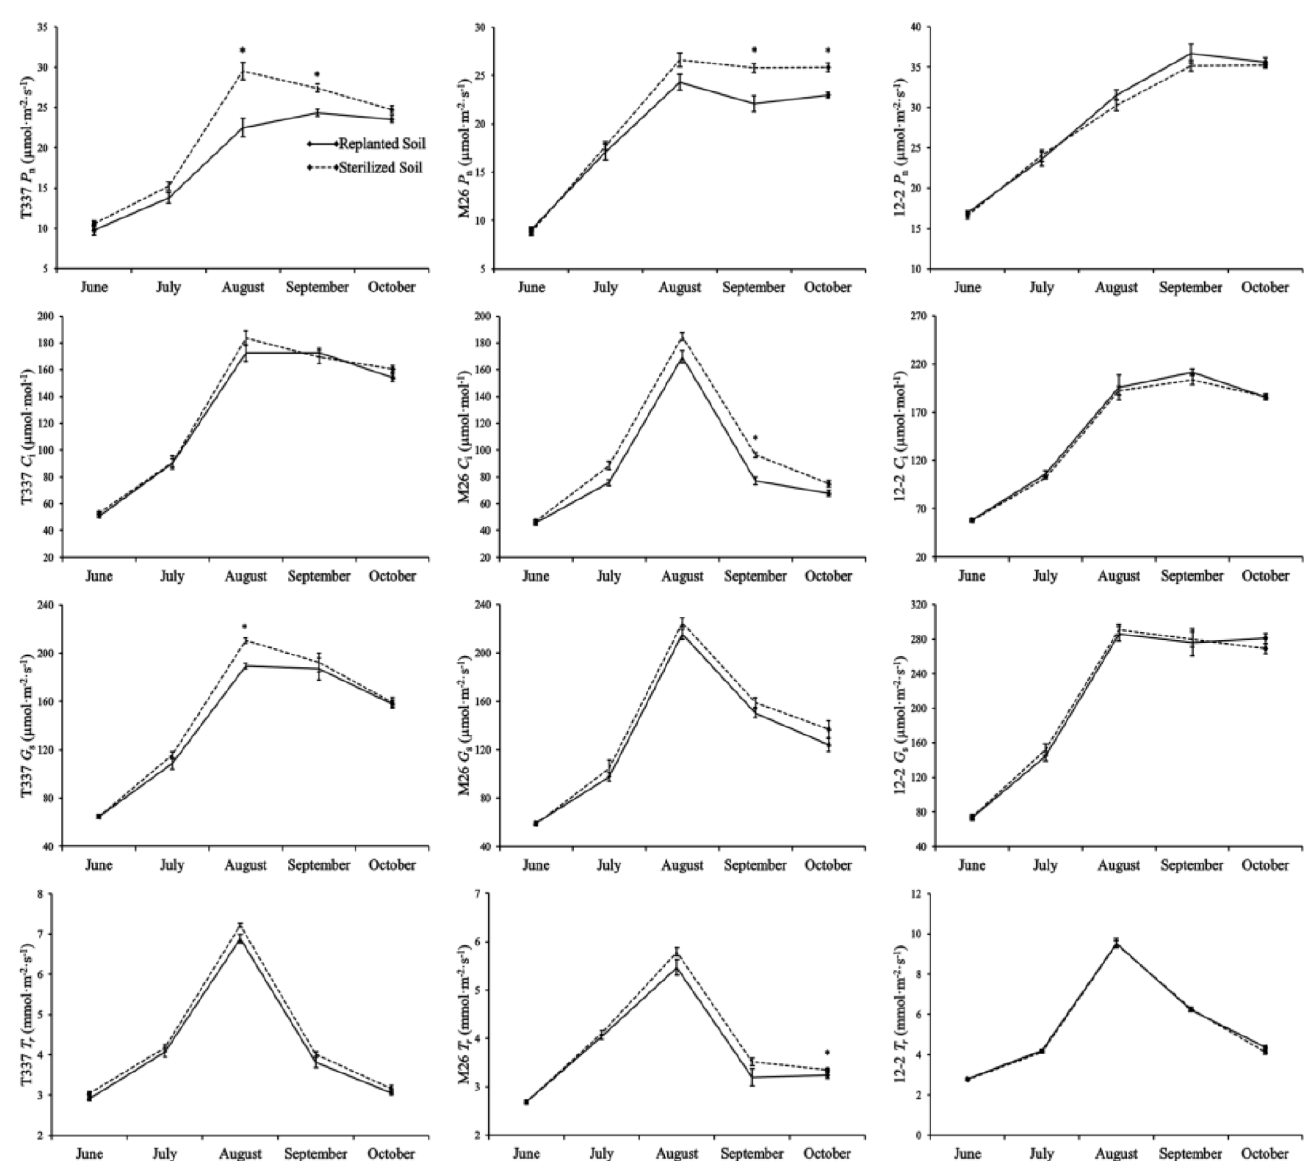
Figure 2. Photosynthesis in the leaves of plants with different rootstock types planted in sterilized and replanted soil.